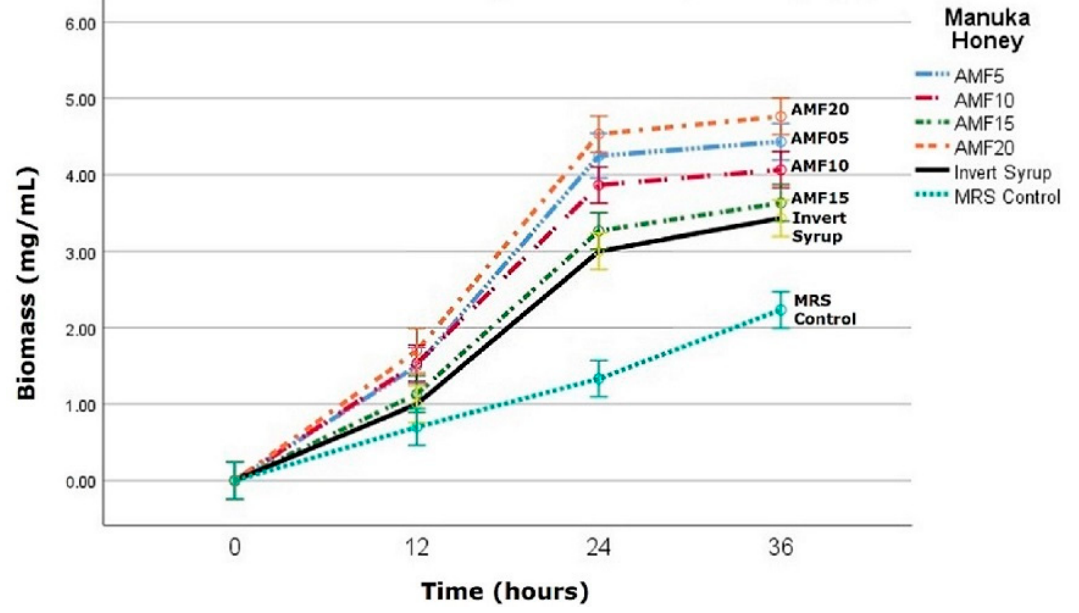
Figure 1. Biomass (mg/mL) of L. reuteri DPC16 in fermented MRS broth with Manuka honey (AMF TM 5 + , 10 + , 15 + and 20 + ), invert syrup and unsweetened control during the fermentation period (12, 24 and 36 h). Error bars represent the standard error of mean (SEM).